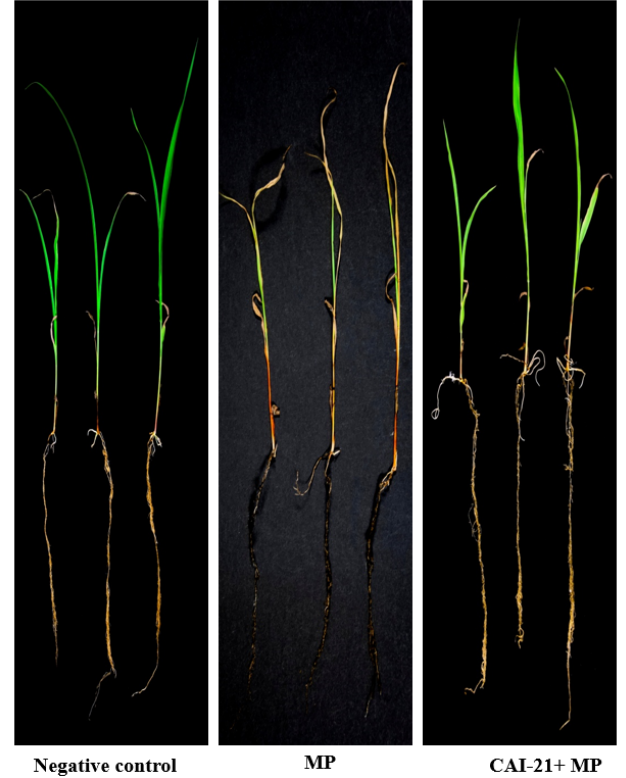
Figure 3. In vivo biocontrol potential of S. albus CAI-21 against charcoal rot as determined by blotter paper assay of sorghum roots. MP, M.